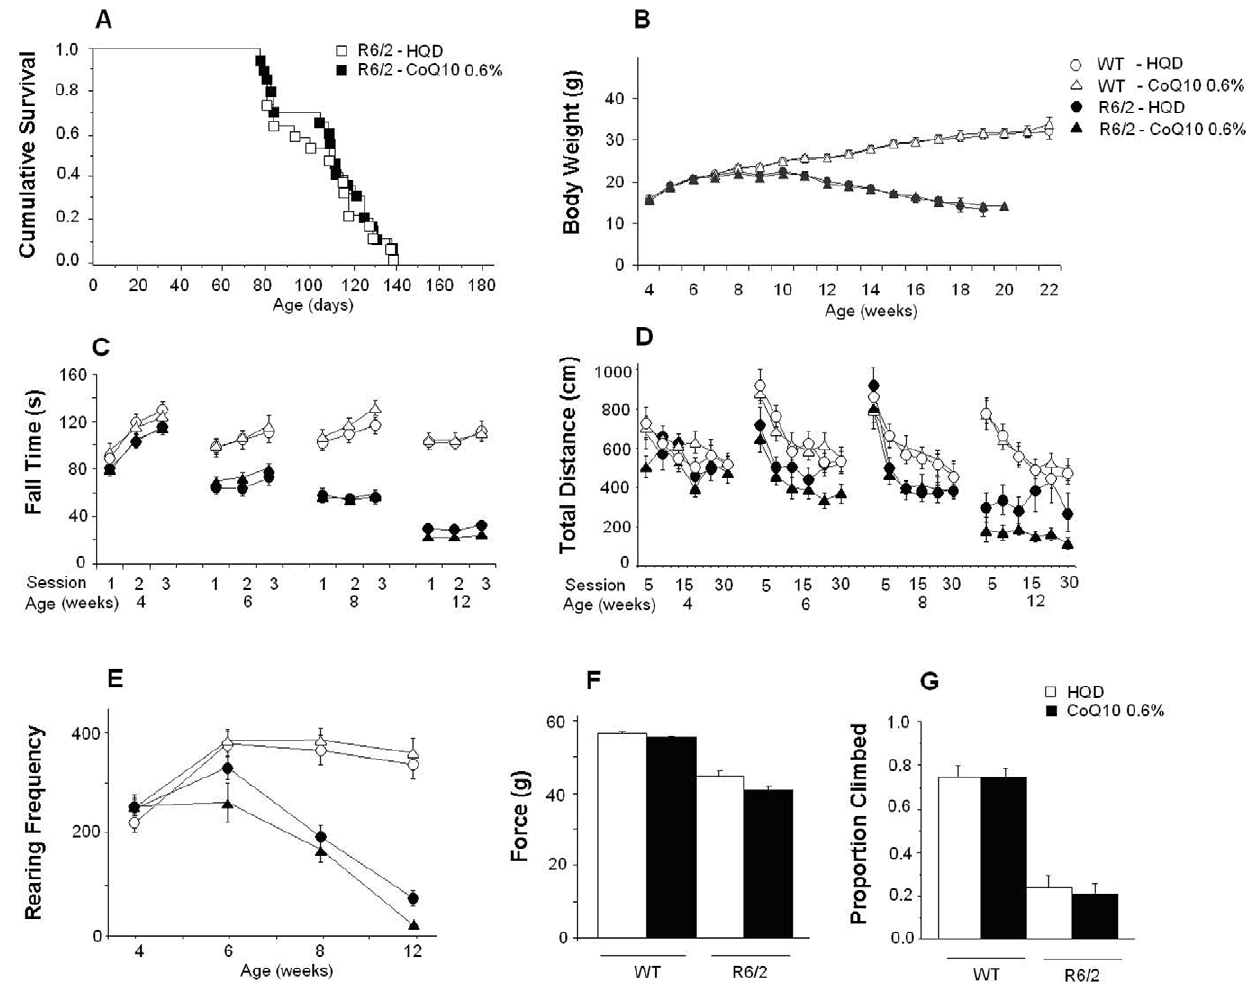
Figure 2. Effect of the administration of 0.6% of CoQ10 in food in R6/2 mice. WT mice and R6/2 mice were fed with a diet with HydroQsorb (HQD) alone or with 0.6% CoQ10 in HQD. There was no treatment effect on survival (A). CoQ10 significantly decreased the body weight (B) of R6/2 males between 6 and 10 weeks of age (treatment 6 age 6 gender interaction: F(22,330)=4.1, p , 0.0001; simple main effects: ps , 0.05). There were no effects of treatment on the latency to fall from the rotarod (C). In mutant females, CoQ10 diminished locomotor activity in the open field (D). Treated R6/2 females were significantly hypoactive at 4 weeks (0–5 min), 6 weeks (last 10 min), at 12 weeks of age (20 to 25 min; treatment 6 gender interaction: F(1,35)=6.7, p , 0.02; simple main effects: p , 0.007; treatment 6 age 6 time interaction: F(30,460)=3.4, p , 0.0001; simple main effects: ps , 0.05). R6/2 treated mice reared significantly less in the open field (E) at 6 weeks of age compared with untreated mutant mice (treatment 6 age interaction: F(3,92)=3.2, p , 0.03; simple main effects: p , 0.035). There were no treatment effects on either grip strength (F) or in the rearing